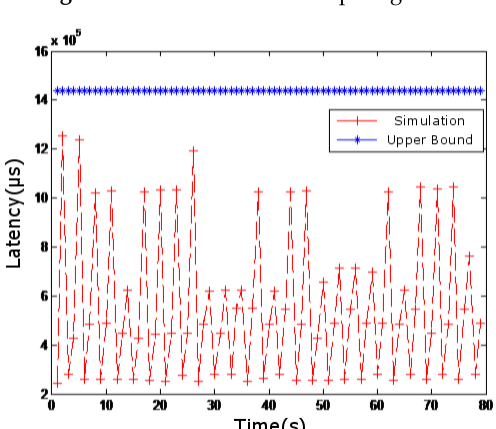
Figure 8. Results superimposing competing flows in Figures 4–6.